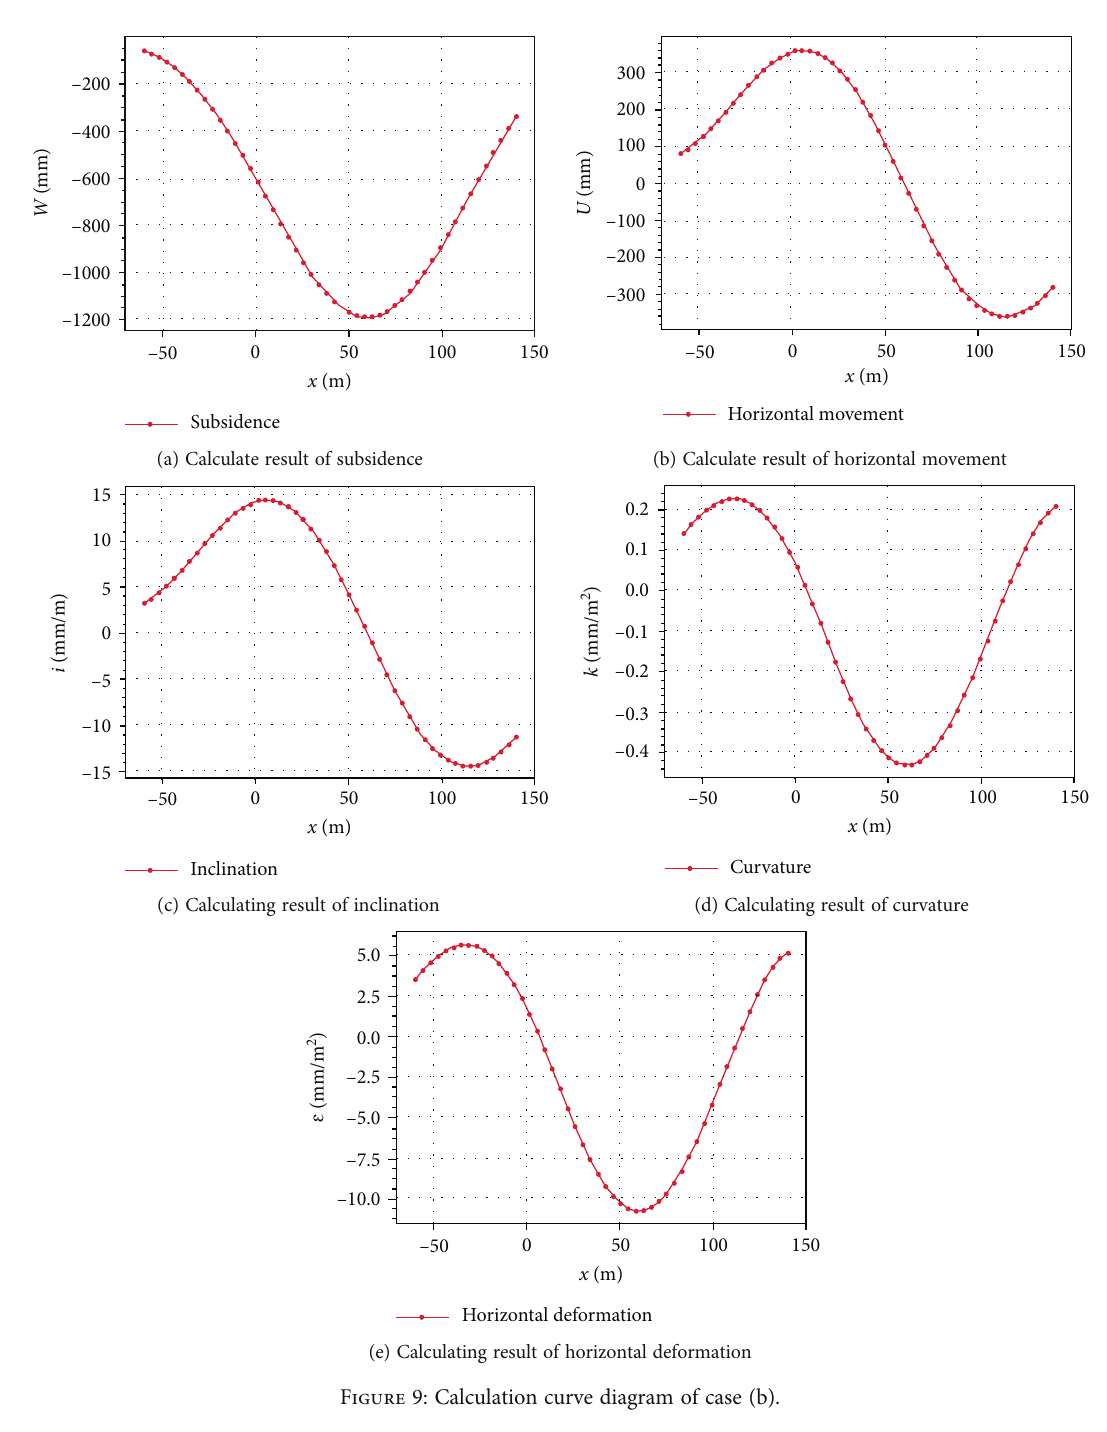
Figure 9: Calculation curve diagram of case